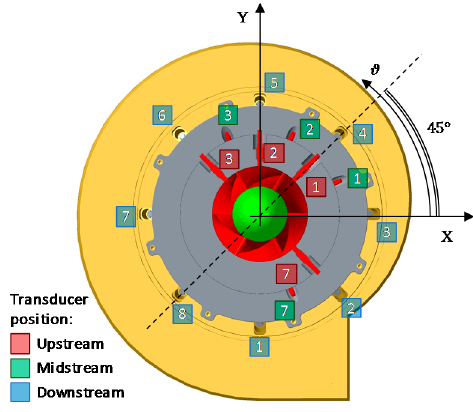
Figure 3. Piezoelectric pressure transducers positions. Table 2. Pressure taps exploited for the present campaign.